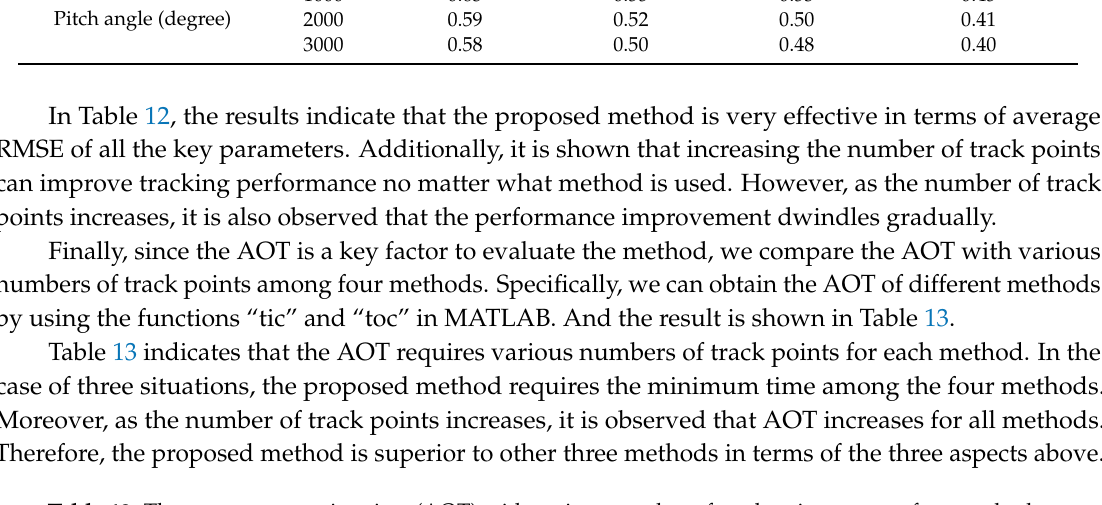
Table 13. The average operation time (AOT) with various number of track points among four